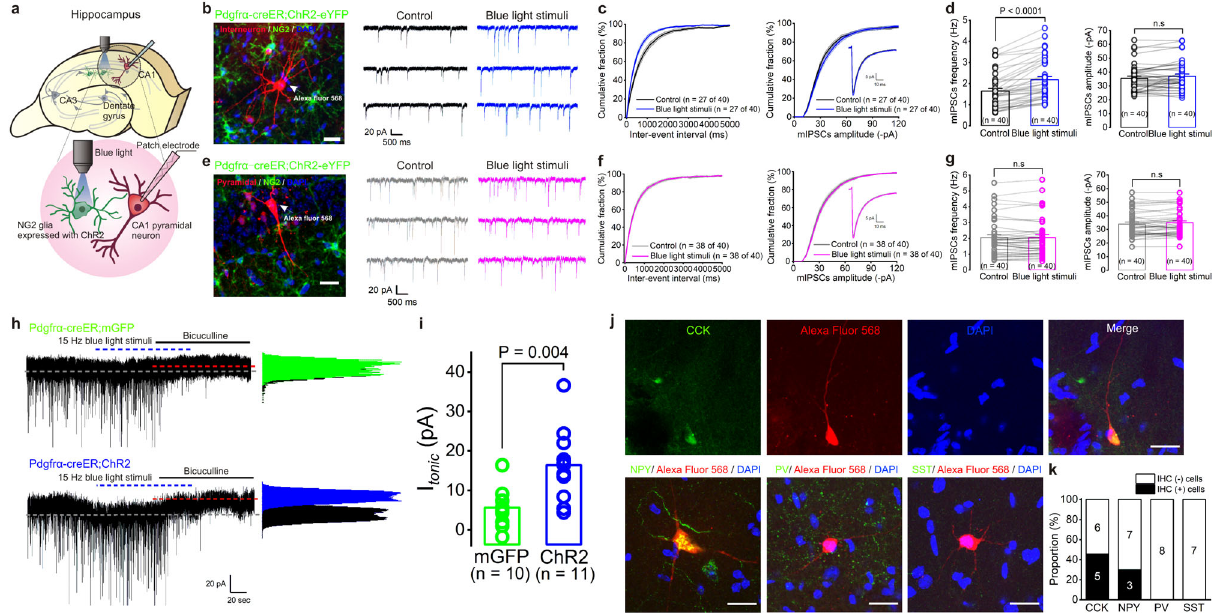
Fig. 2 Selective enhancement of phasic and tonic inhibition onto interneurons by NG2 glia photostimulation. a Cartoon illustrating the anatomic location of cells for electrophysiology and photostimulations in CA1 region of the hippocampus at postnatal 4 – 6 weeks. b Representative traces (right panel) showing an increase of frequency but not the amplitude of mIPSCs from a whole-cell patched interneuron loaded with Alexa Fluor 568 in the patch pipette (left panel) after NG2 glia photostimulation in CA1 region. Scale bar, 20 μ m. c and d Summary graphs for cumulative distributions of mIPSCs frequency and amplitude ( c ) and mean frequency and amplitude of mIPSCs ( d ) from recorded interneurons. n = 40 cells, two-tailed Wilcoxon-matched pairs test, P values as indicated. Note that the average of GABA A Rs kinetics in the inset shows no change after NG2 glia photostimulation. e Representative traces (right panel) showing no change of frequency and amplitude of mIPSCs of a whole-cell patched pyramidal neuron loaded with Alexa Fluor 568 in the patch pipette (left panel) after NG2 glia photostimulation in CA1 pyramidal cell layer. Scale bar, 20 μ m. f and g Summary graphs for cumulative distributions of mIPSCs frequency and amplitude ( f ) and mean frequency and amplitude of mIPSCs ( g ) in recorded pyramidal neurons. n = 40 cells, two-tailed paired t test, n.s. indicates not signi fi cant. Note that the average of GABA A Rs kinetics in the inset shows no change after NG2 glia photostimulation. h Representative traces showing an increase of GABA A R-mediated tonic current in an interneuron after NG2 glia photoactivation (lower panel) from Pdgfr α -creER TM ;ChR2-eYFP mouse compared with its basal tonic inhibition in an interneuron (upper panel) from Pdgfr α -creER TM ;mGFP mouse. i Summary graph showing a signi fi cant enhancement of tonic GABA current in ChR2 compared with its mGFP control after blue light stimulation. Tonic GABA currents: 5.63 ± 1.59 pA, n = 10 cells in mGFP control vs. 16.38 ± 2.78 pA, n = 11 cells in ChR2, two-tailed unpaired t test, P = 0.004. j Representative images show post-immunostaining CCK-, NPY-, PV-, or SST- antibody with Alexa Fluor 568-loaded interneurons, which exhibited an enhanced frequency of mIPSCs after NG2 glia photoactivation. Scale bars, 20 μ m. k The summary graph shows the proportion of each CCK + , NPY + , PV + , or SST + interneurons from a total of 36 responsive interneurons recorded. Data are presented as mean values ± SEM and the error bar represents